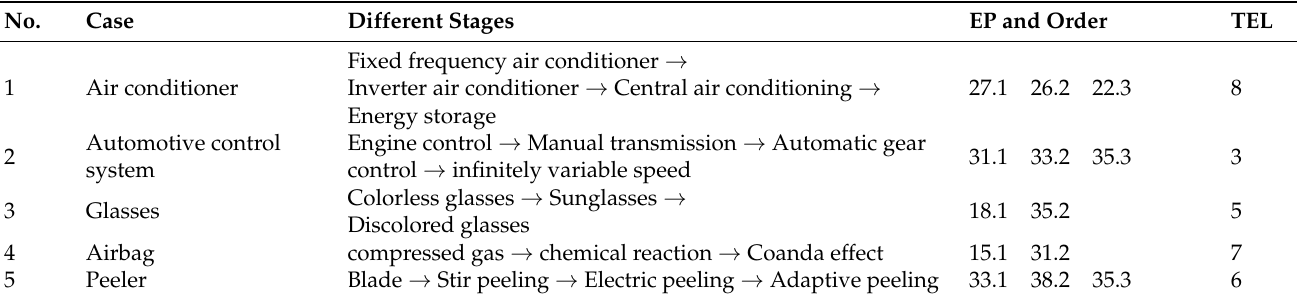
Figure 1. Training results: ( a ) training process; ( b ) test result. Table 1. Part of the training cases.